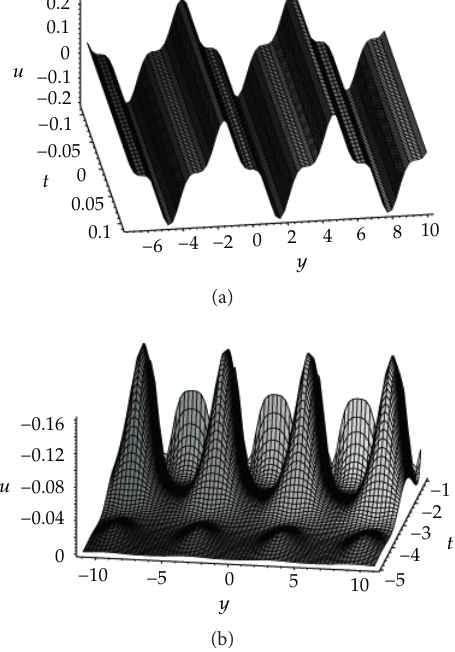
Figure 2: (a) The figure of 𝑢 3 as 𝑝 = −1, 𝑞 = 1, 𝑟 = −1, 𝜏(𝑦) = cos (𝑦) , 𝜉 0 = 0, 𝑥 = sin (𝑡) . (b) The figure of 𝑢 9 as 𝑝 1 = 1, 𝑐 1 = = 1 , 𝜏(𝑦) = sin (𝑦), 𝑥 = sin (𝑡) 1, 𝑝 2